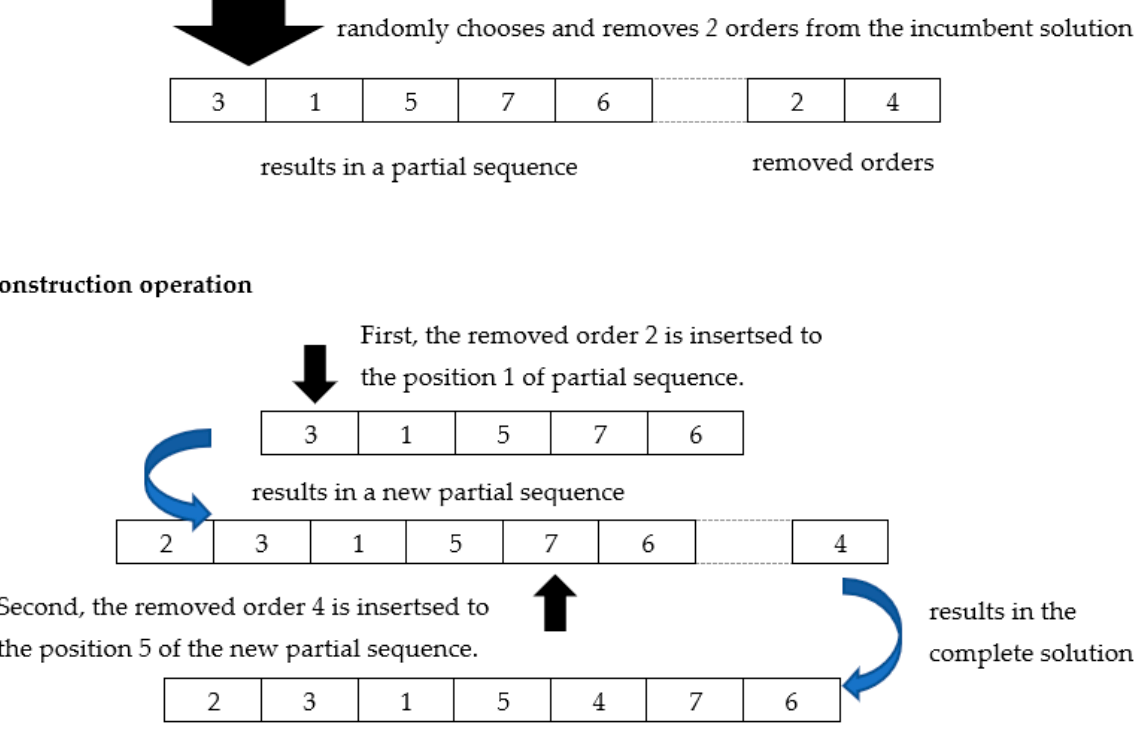
Figure 4. An example for the DC procedure.